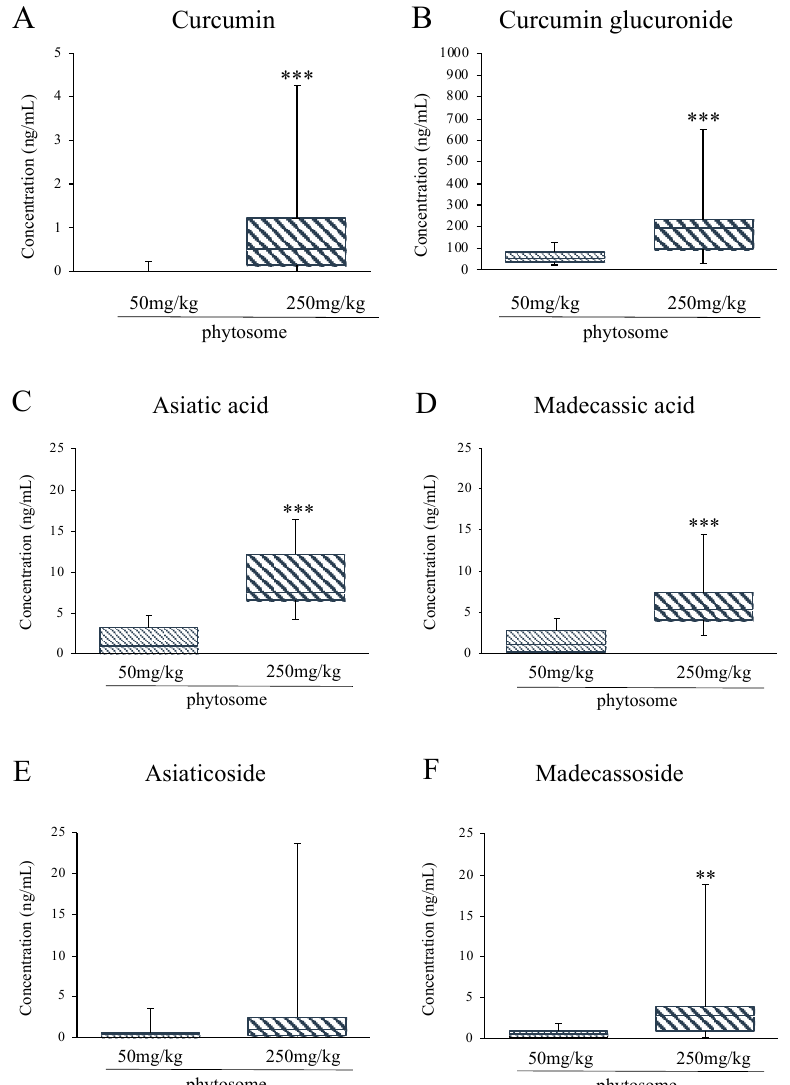
Figure 1. Concentration of Curcumin ( A ), Curcumin glucuronide ( B ), Asiatic acid ( C ), Madecassic acid ( D ), Asiaticoside ( E ) and Madecassoside ( F ) in the plasma of rats following the repeated oral administration of the phytosomal preparation. Data are expressed in ng / mL as are represented as boxes and whiskers graphs. ** p < 0.01, *** p < 0.001 vs. vehicle; Mann-Whitney nonparametric test.